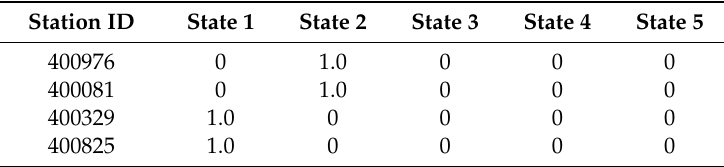
Table 2. Determined π in four regime identification models.